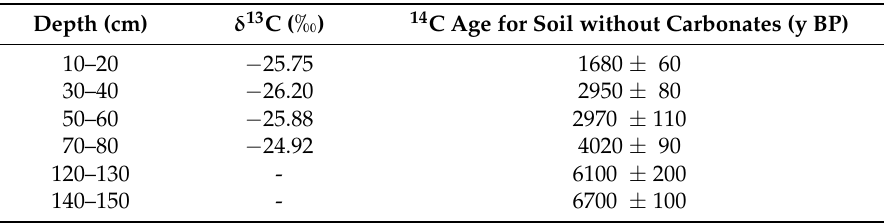
Table 1. Radiocarbon data for Haplic Chernozem/Typic Hapludoll located in the Kursk (36 ◦ 10 (cid:48) E; 51 ◦ 45 (cid:48) N) native steppe with MAP a = 715 mm and MAT b = 5.3 ◦ C (uncalibrated data from